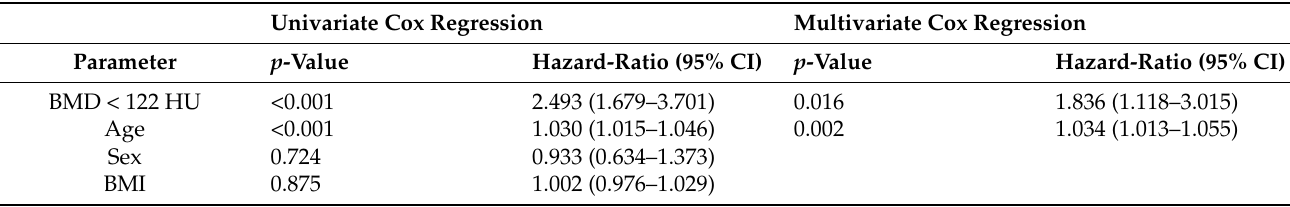
Figure 4. BMD is a prognostic factor for overall survival in critically ill patients. ( A ) ICU patients with a baseline BMD value < 152 HU have significantly impaired OS compared to patients with a BMD value above 152 HU. ( B ) Kaplan–Meier curve analysis reveals that OS is particularly poor in patients with BMD values below the 25th percentile. In these patients, median OS is only 3.29 weeks compared to 261.57 weeks in patients whose BMD upon ICU admission ranged within the upper quartile. ( C ) When applying the optimal prognostic cut-off value of 122 HU, Kaplan – Meier curve analysis shows significantly shorter OS in patients with a BMD value < 122 HU compared to patients with a BMD value above this cut-off value. Table 3. Cox regression analyses including individual BMD and other clinicopathological parameters for the prediction of overall